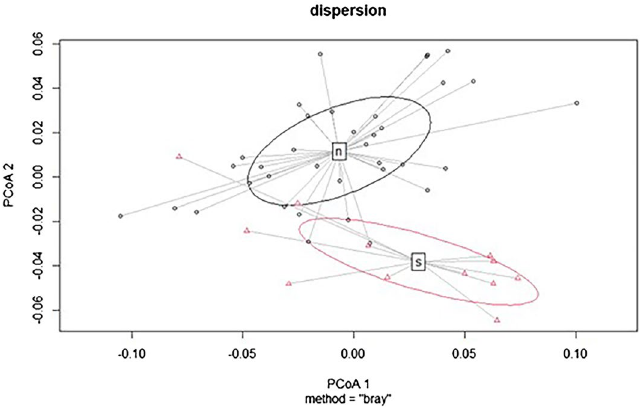
Figure 7. Differentiation of two coniferous forest types using mean, max, min, and Std RHL-10% (data from April 20, 2019), where the P value is less than 0.001. Abbreviations: s – 9410 – Acidophilous Picea forests of the montane to alpine levels and n – planted spruce